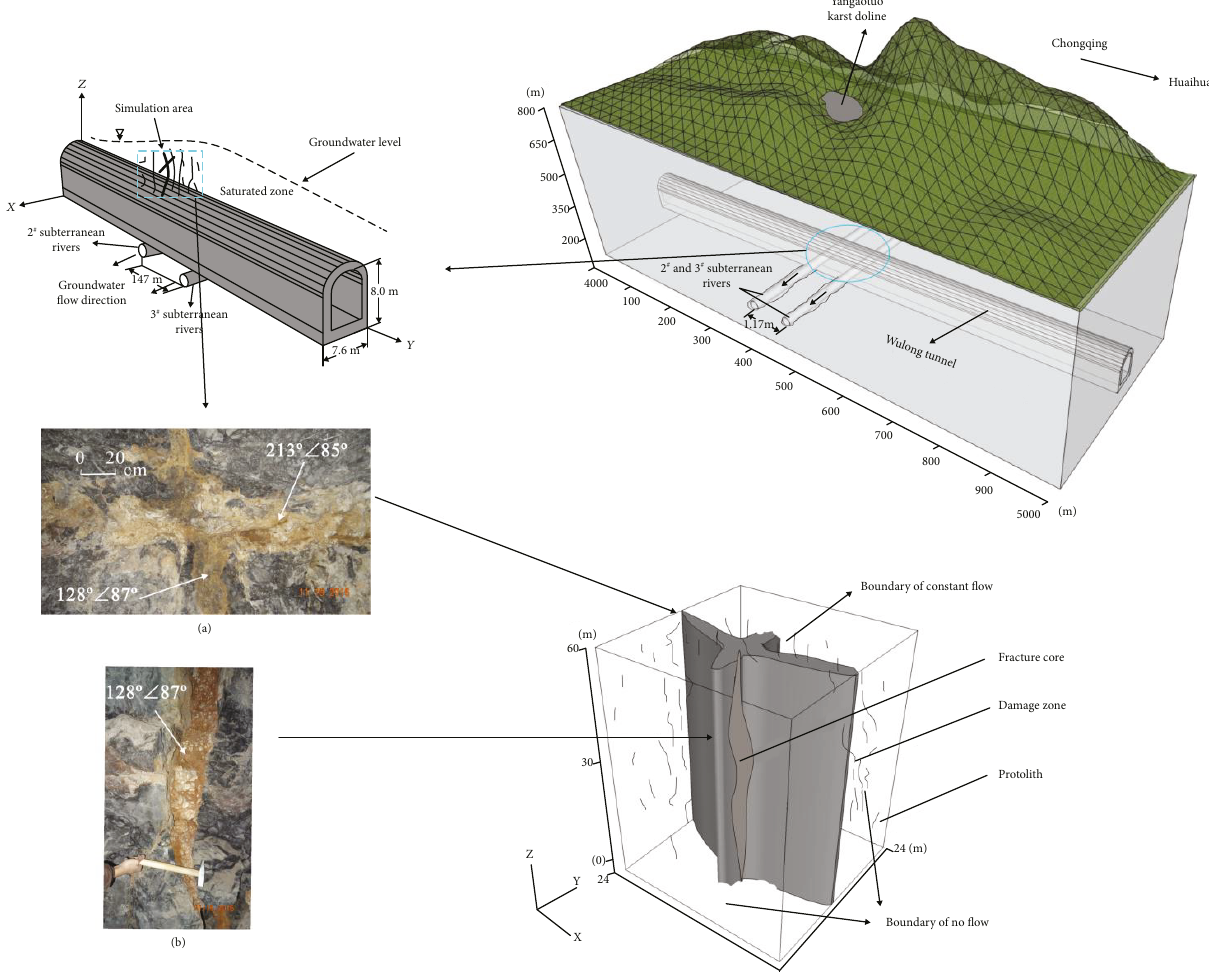
Figure 5: Conceptual model of the study area.